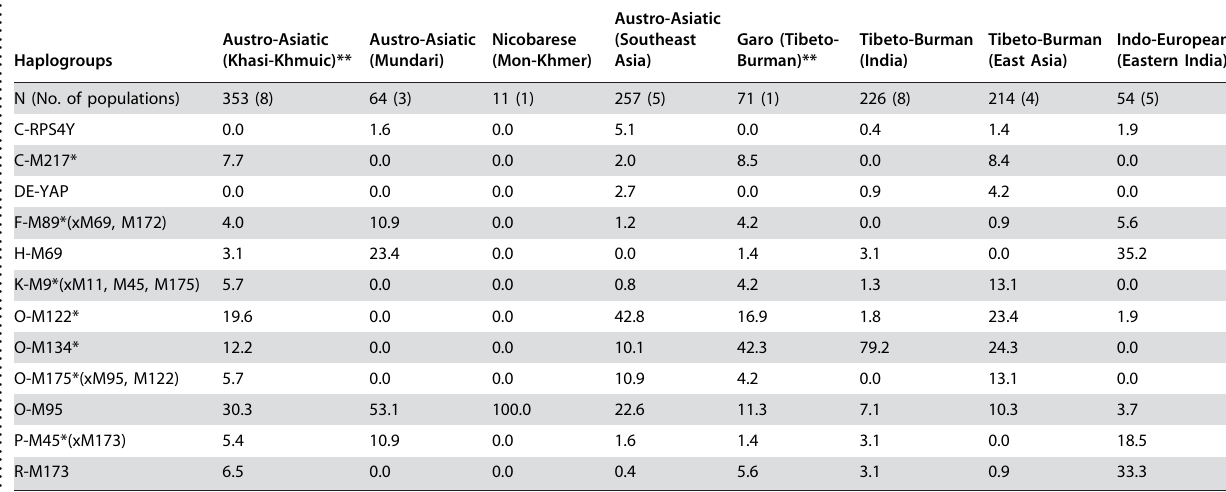
Table 5. Y-haplogroup frequencies in different linguistic populations of South and Southeast Asia. .. ... .... ... ... .... ... ... .... ... ... .... ... ... .... ... ... .... ... ... .... ... ... .... ... ... .... ... ... .... ... ... .... ... ... .... ... ... .... ... ... .... ... ... .